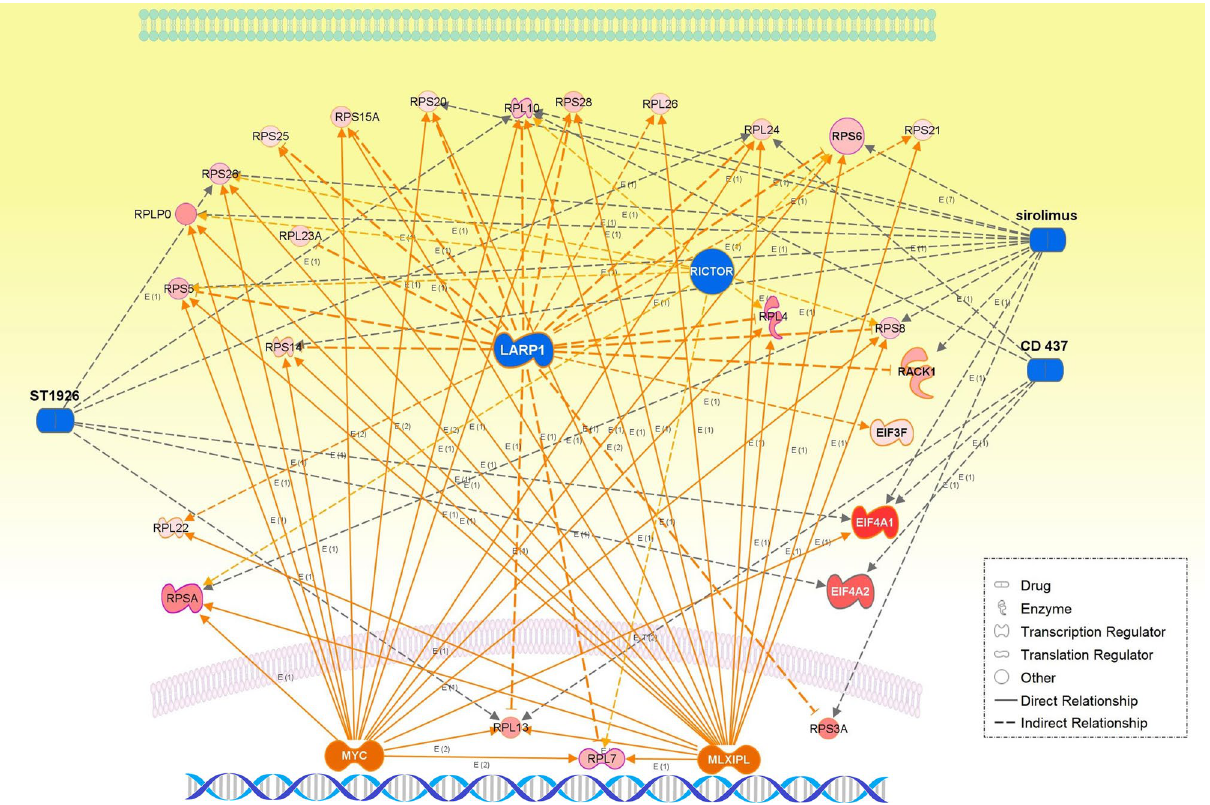
Figure 6. The integrative networks of representative master and participating regulators predicted for the WM27 and WM28 modules, together with chemical drug interventions (CD 437, ST1926, and sirolimus